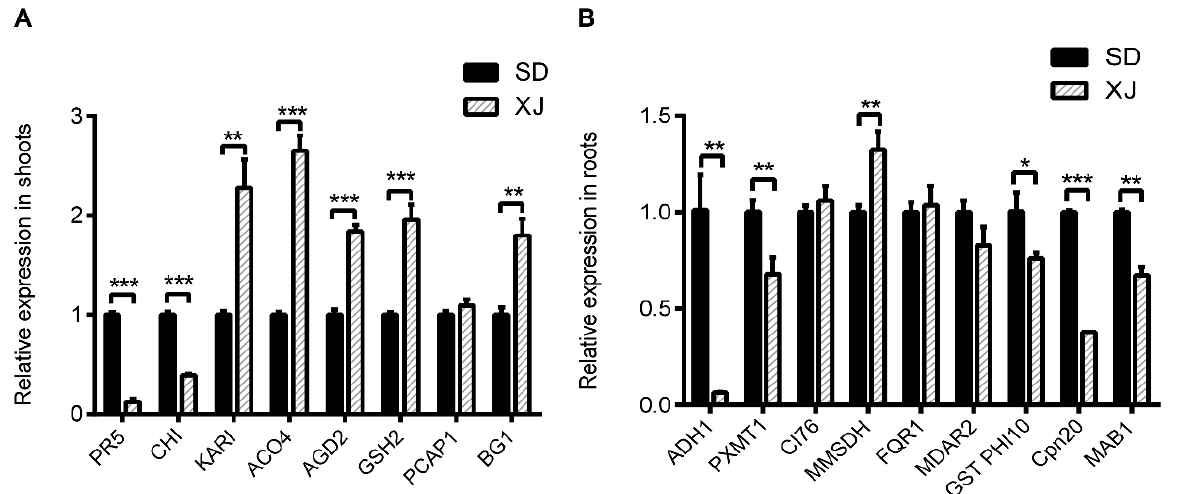
Figure 7. Relative transcript levels in two Eutrema plants under normal hydroponic conditions for 6 weeks. ( A ) Differentially expressed genes in shoots. ( B ) Differentially expressed genes in roots. Data are presented as mean ± SD obtained from 3 biological replicates. t -test was used to analyze the changes in the gene expression (* p < 0.05, ** p < 0.01, and *** p < 0.001). The abbreviations for Figure 7 were: PR5, pathogenesis-related protein 5; CHI, endochitinase; ACO4, 1-aminocyclopropane-1-carboxylate oxidase 4; AGD2, LL-diaminopimelate aminotransferase; GSH2, glutathione synthetase; PCAP1, plasma membrane-associated cation-binding protein 1; BG1, glucan endo-1,3-beta-glucosidase; KARI, ketoacid reductase isomerase; ADH1, alcohol dehydrogenase class-P; PXMT1, paraxanthine methyltransferase 1; CI76, NADH dehydrogenase [ubiquinone] iron-sulfur protein 1; MMSDH, methylmalonate-semialdehyde dehydrogenase; FQR1, NAD(P)H dehydrogenase (quinone); MDAR2, monodehydroascorbate reductase 2; GST PHI10, glutathione S-transferase F10; Cpn20, 20 kDa chaperonin; MAB1, pyruvate dehydrogenase E1 component subunit beta-1.